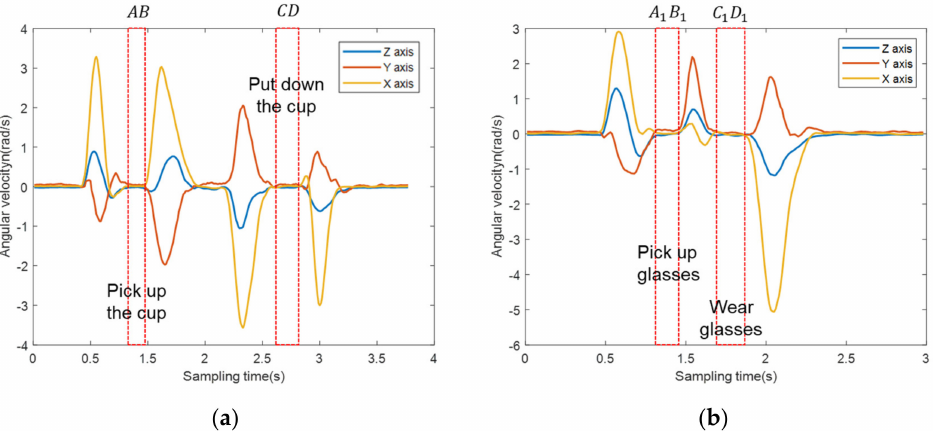
Figure 5. Angular velocity curve of the movement of a healthy person. ( a ) Angular velocity curve of drinking. ( b ) Angular velocity curve of wearing glasses.